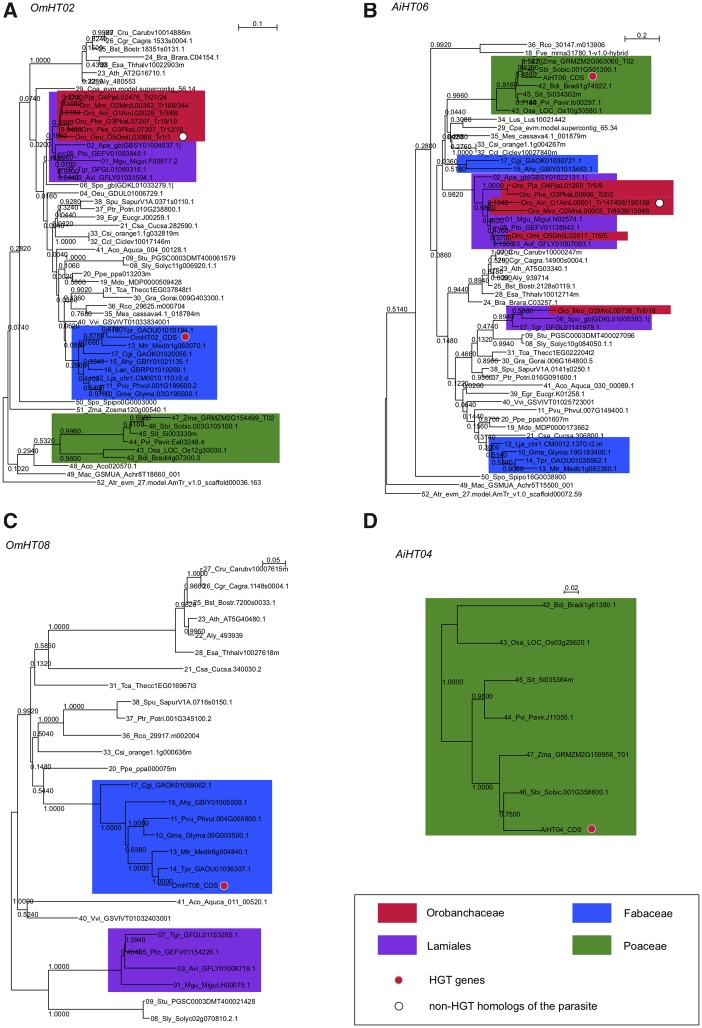
—Four representative gene trees of the HGT genes with their homologs in 52 angiosperm species. See the text for details.